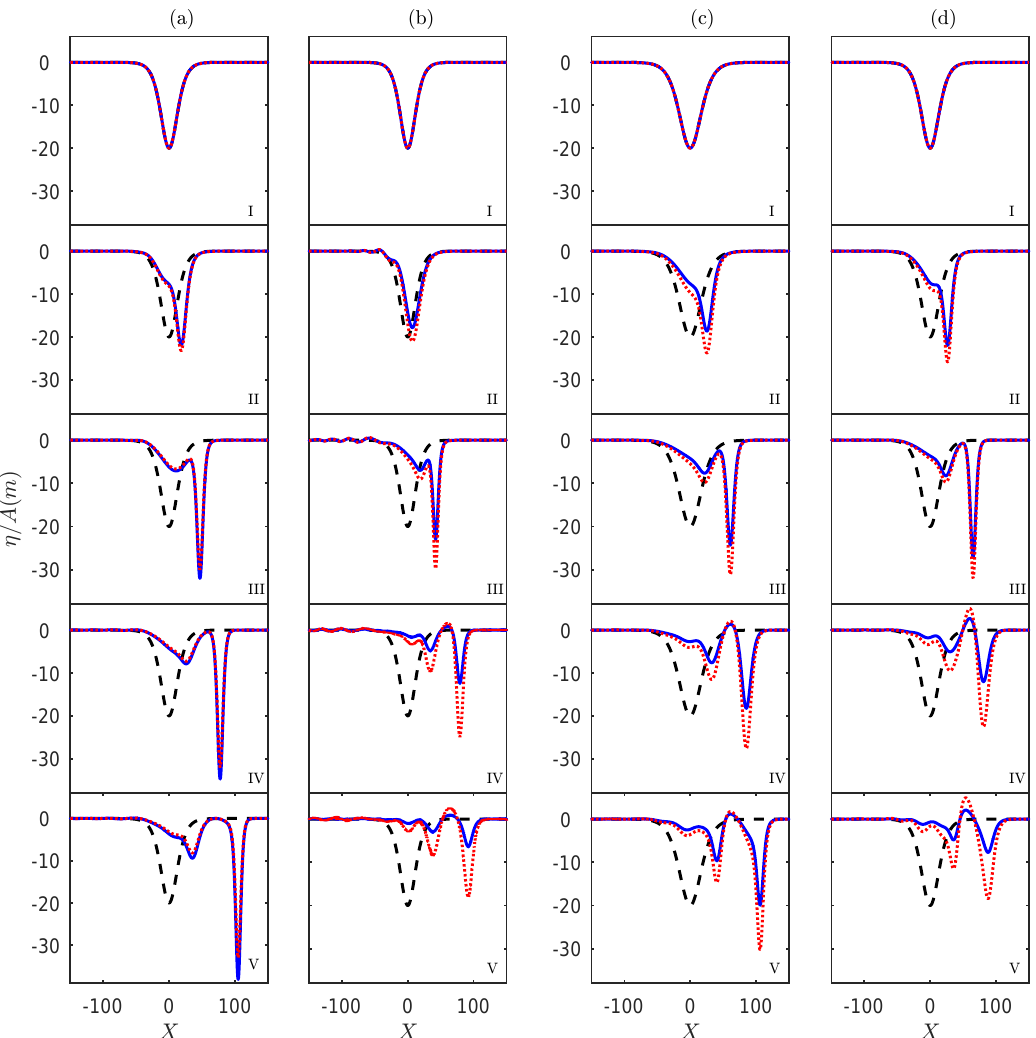
Figure 16. A numerical simulation of the vKdV Equation (5) of a transect close to the Amazon River Mouth case in summer ( a , b ) and winter ( c , d ) conditions, with u 0 = 0 ( a , c ) or u 0 (cid:54) = 0 ( b , d ), respectively. The initial condition is the solitary wave (black, dash), the numerical solution is ˜ A (red, dot) and the physical solution is η (blue, solid). From top to bottom, the distances from the initial point are (I) 0 km, (II) 36.5 km, (III) 73 km, (IV) 109.5 km, (V) 146 km,